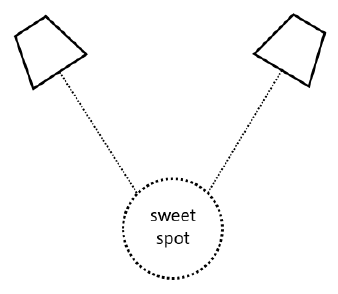
Figure 1. Sweet spot of the stereophonic system.